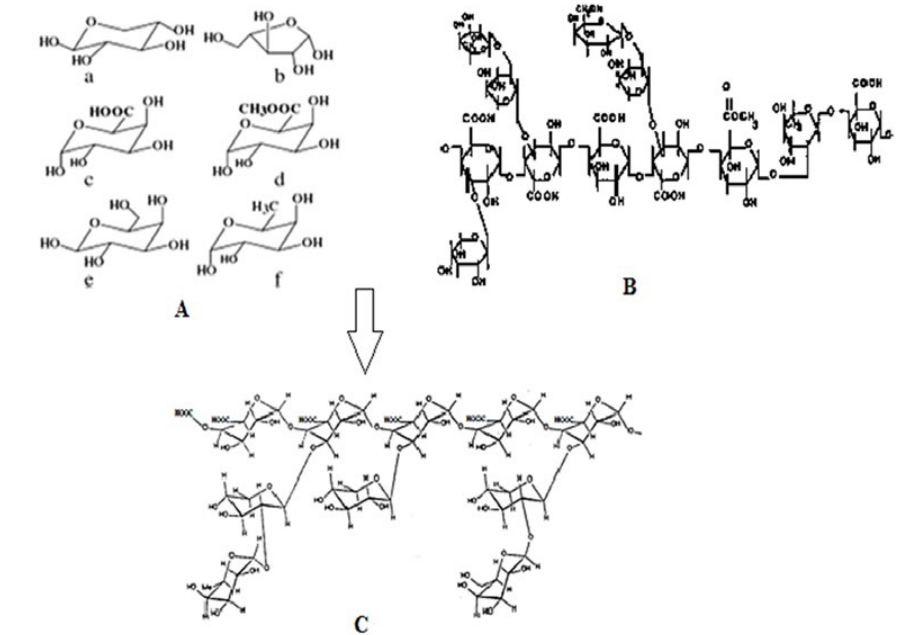
Figure 1: (A) Main chemical building units of the GT) β-D-xylose L-arabinose,) α-D-galacturonic acid, d) α-D1-galacturonic acid methyl ester) β-Dgalactose )1 α-L1-fucose, (B) The main structural of GT, (C) Structure of Bassorin [4]